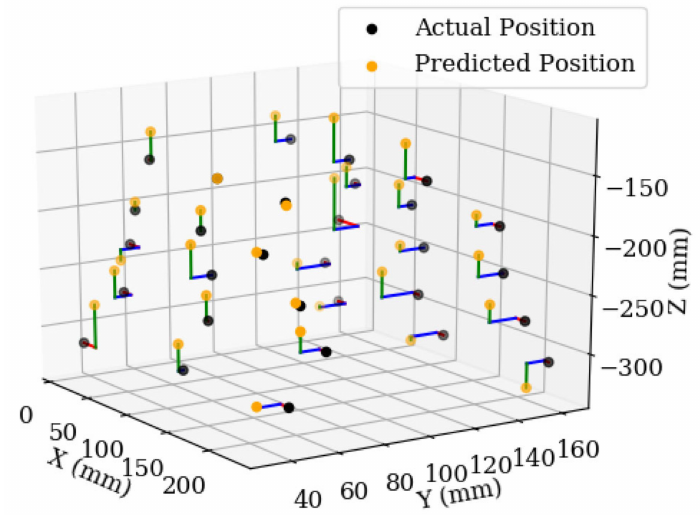
Figure 14. Actual and estimated position of the 30 test leaves. Each leaf was positioned to test the full range of the robot, to see if there was a bias in any